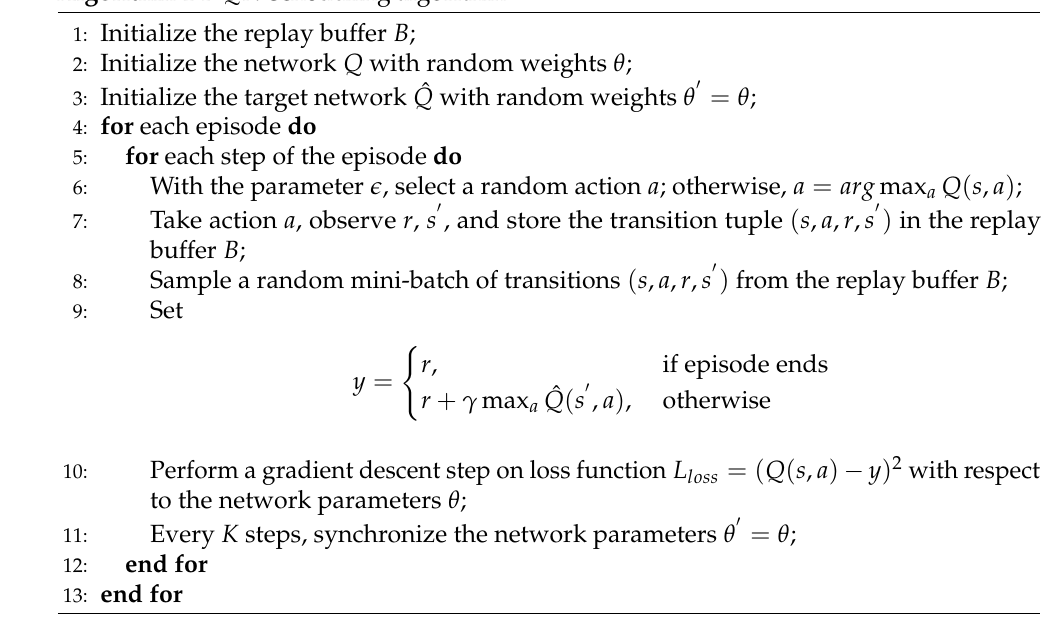
Algorithm 1 DQN scheduling